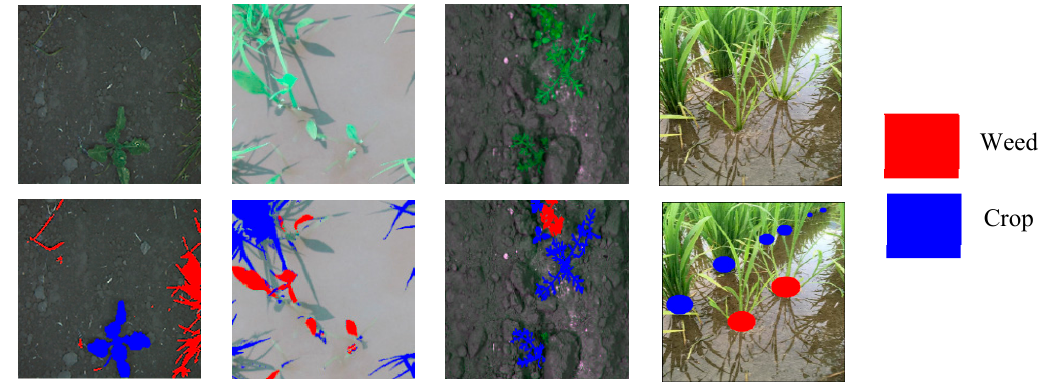
Figure 1. Crops and weeds segmentation datasets: BoniRob on left, followed by rice seeding weed, carrot weed, and paddy-millet: red color indicates weed and blue crop.